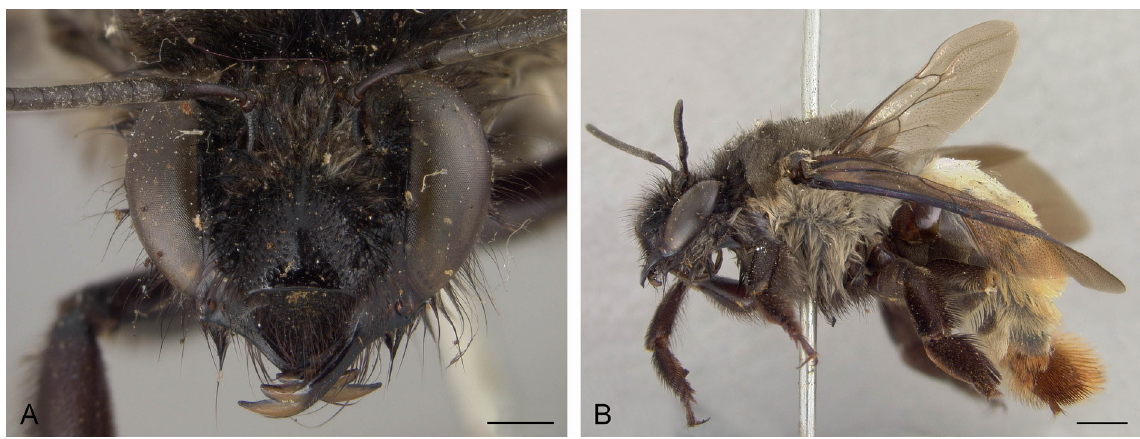
Fig. 25. Centris chlorura Cockerell, 1919, holotype, ♀ (NMNH; USNM ENT 00534190). A . Frontal view. B . Habitus, lateral view. Scale bars: A = 1 mm; B = 2